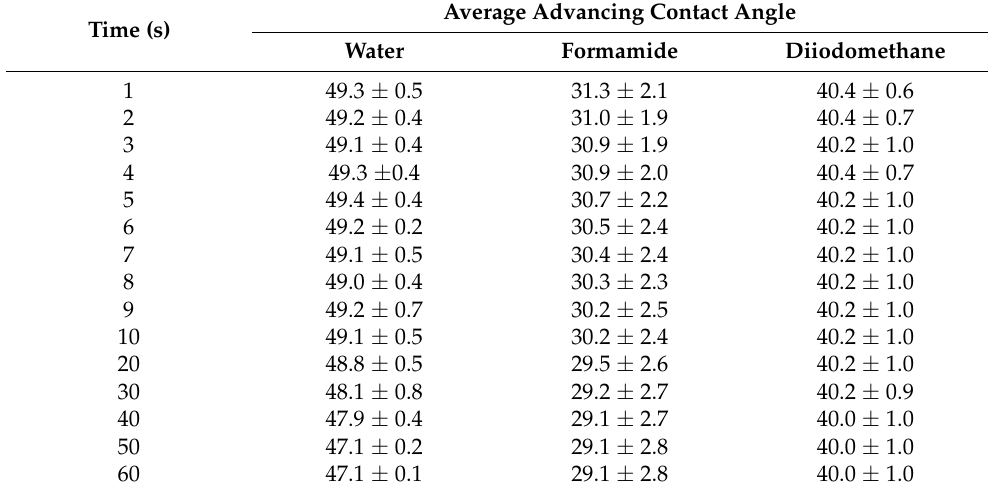
Table 3. Average advancing contact angles of the test liquids measured on the single DOPC monolayer deposited on PET air during 60